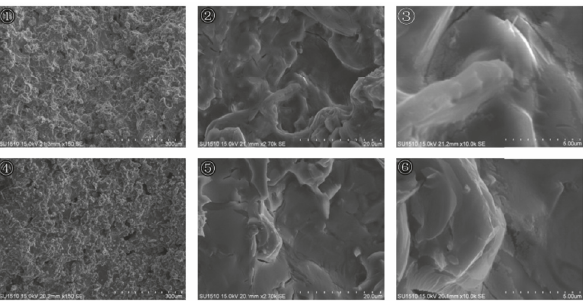
Figure 9: SEM photo of 900 ∘ C sintered samples (HLW pH=3, ABC Fe DEF 9% Fe 2 O 3 free, 2 O 3 addition).